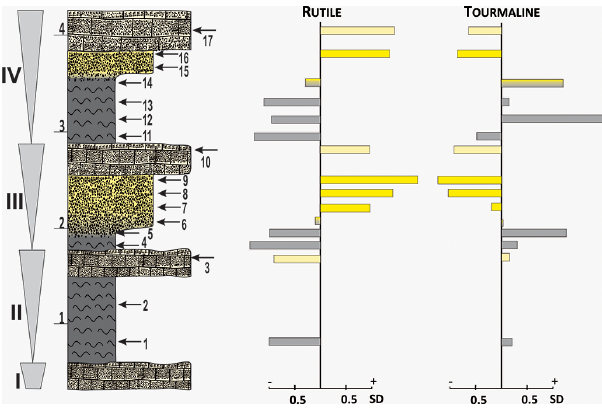
Figure 6. Vertical chart of Z -score standardized rutile and tourma- line abundance in the Szozdy section. The vertical line represents the mean abundance of the analyzed minerals over the whole sec- tion. The bars are associated with the equivalent samples shown on the stratigraphic column; SD – standard